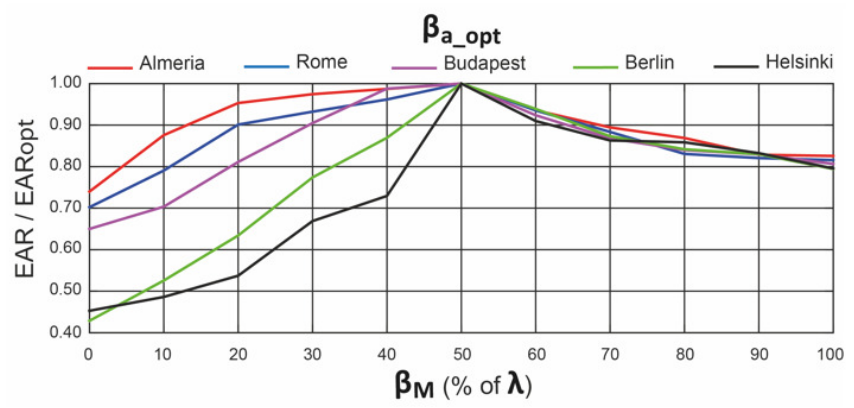
Figure 13. Influence of β M